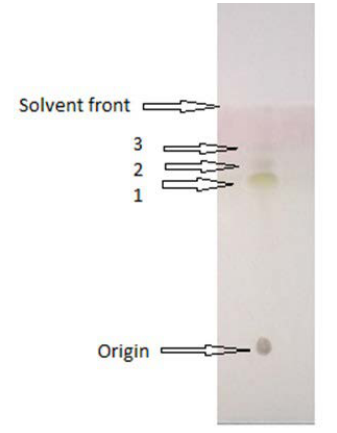
Fig. 6. Thin layer chromatogram showing separation sophorolipid components.